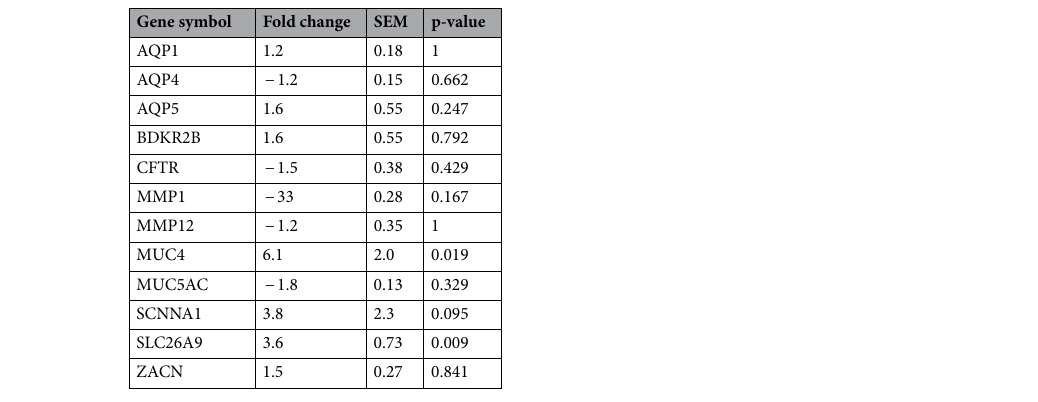
Table 3. Summary statistics for low humidity group RT-qPCR results. SEM standard error of the mean.